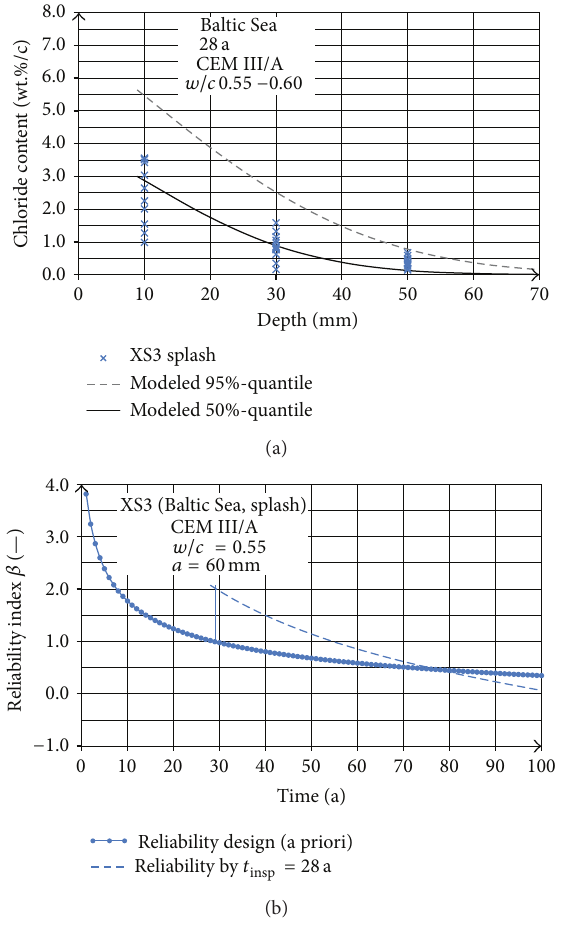
Figure 3: (a): Measured and calculated chloride values of several elements of a marine structure after 28 years’ exposure, (b): assess- ment of the residual service life of the same structure by updating the a priori design by means of the measured chloride profiles.